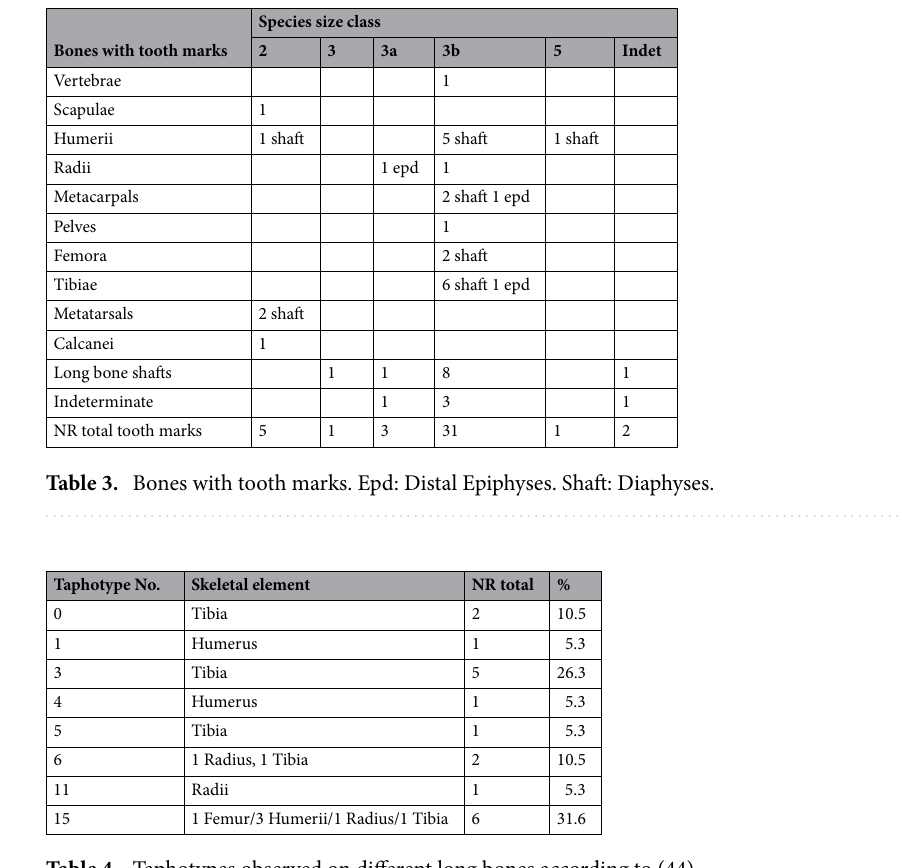
Table 4. Taphotypes observed on different long bones according to (44).